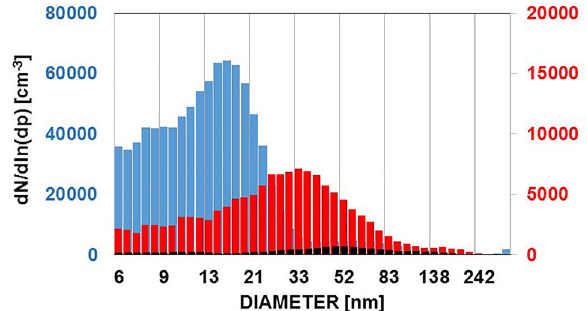
Figure 2. Size distributions measured downwind of shipping lines. Blue: over the islands of Malta/Gozo, June 14, 2013, max concentrations up to 150,000 cm −3 , 2 h from the main shipping route. Horizontal transects over both islands below 600 m ASL, vertical profiles (see supplement) over Gozo between 50 m AGL and 3000 m ASL. Red (right scale): downwind (40 min) of a ‘clean’ Hybrid ferry in the Baltic Sea under nearly total (7/8) cloud cover and a maritime boundary layer of 500 m depth (HYSPLIT). Black (right scale): free troposphere above Malta and Gozo above 800 m ASL up to 3000 m ASL.